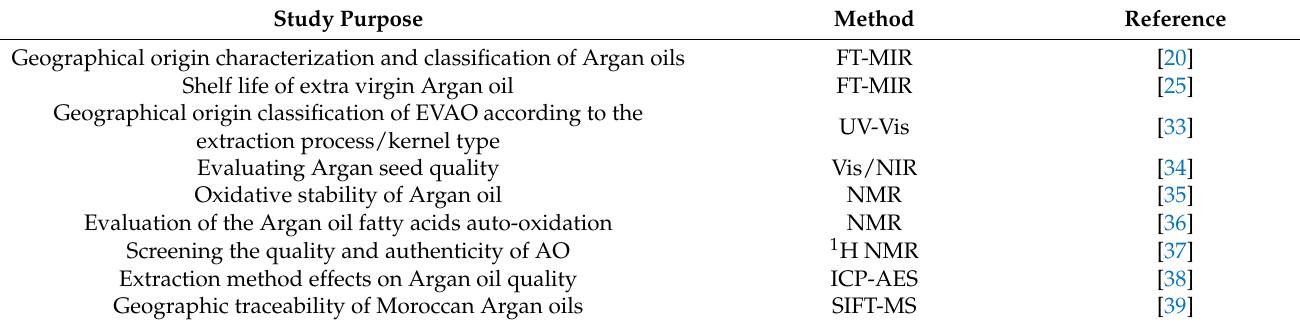
Table 2. Spectroscopic techniques used for the quality control of Argan